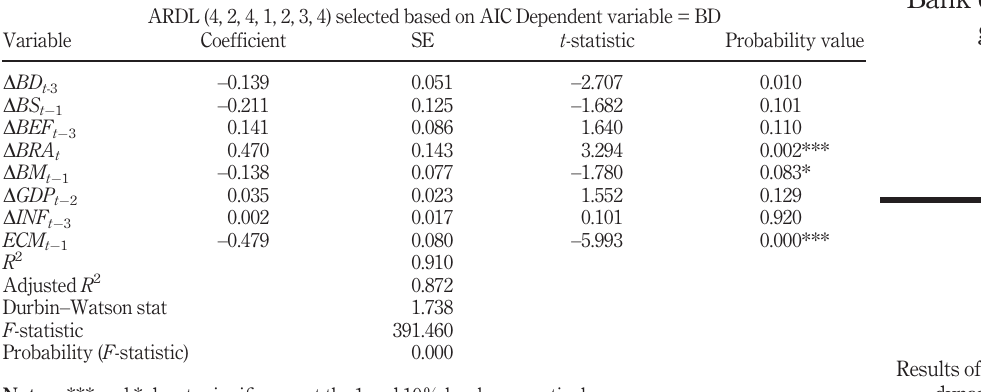
Table 6. Results of short-run dynamic model